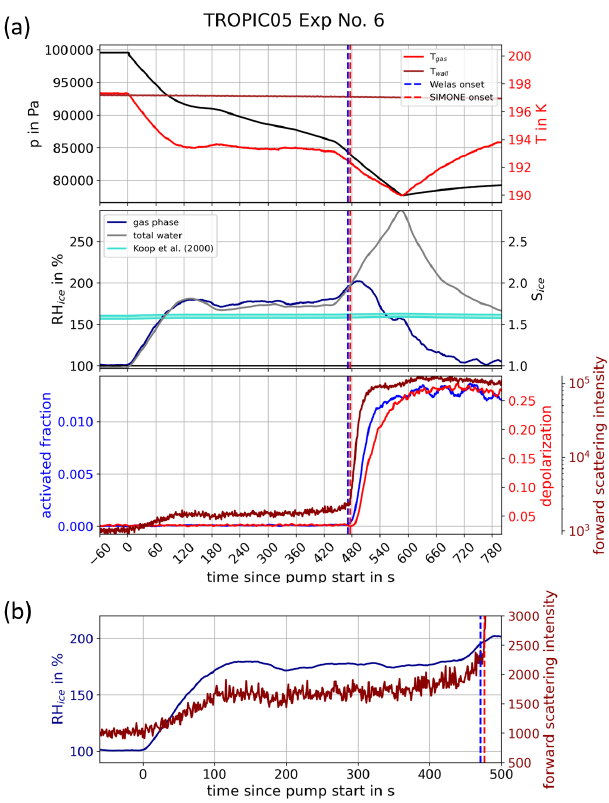
Figure 5. Investigation of kinetic limitations with respect to water uptake in the AIDA chamber. (a) This panel is composed in the same way as Fig. 3. For the experiment shown, started at about 197K, the pump rate was controlled in such a way that the rela- tive humidity with respect to ice stayed relatively constant for about 5min at about 170% and hence above the homogeneous freezing threshold suggested by Koop et al. (2000). For details on this exper- iment, see Sect. 3. (b) Enlarged view of the relative humidity and the forward scattering intensity at the beginning of the